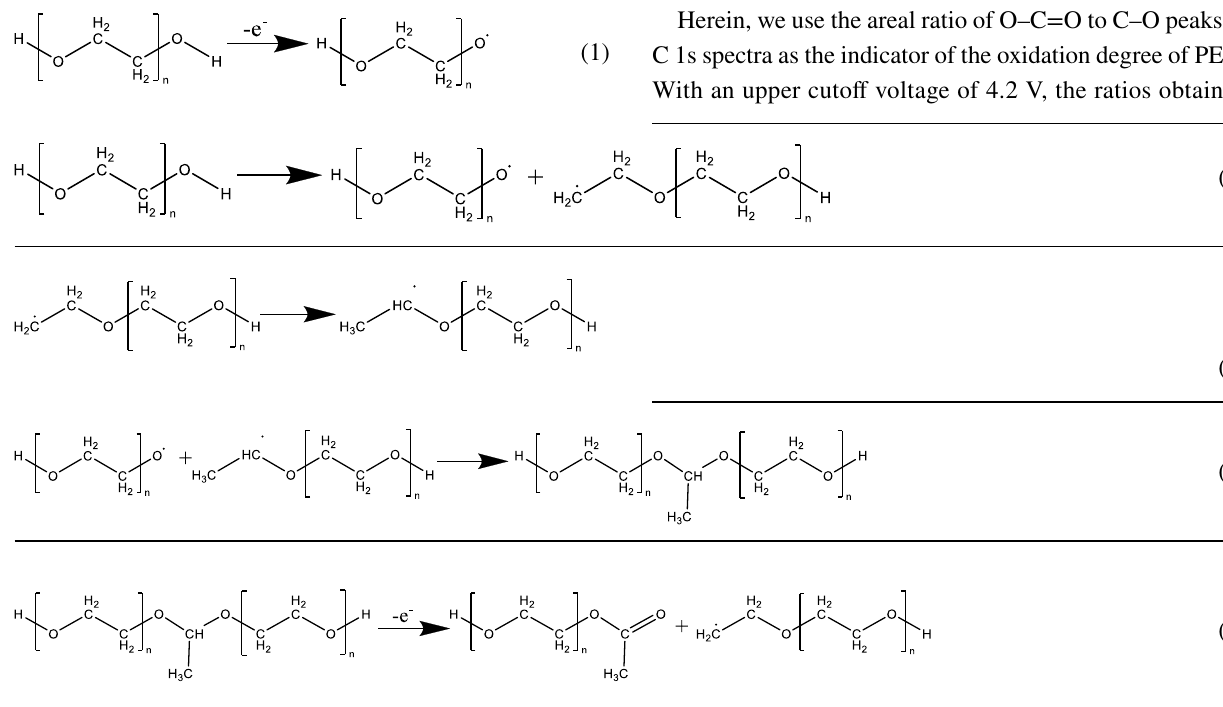
Fig. 3 C 1 s from a pristine PEO-based SPE, PEO-based SPE surface after cycling with b LCO electrode and c LAF@LCO electrode. d EIS spectra of LCO/PEO-LiTFSI/Li cell and LAF@LCO/PEO-LiTFSI/Li cell after cycling. HRTEM images of e LCO and f LAF@LCO particles after cycling. Cycled samples were obtained from the ASSLBs after 50 cycles in the voltage range of 3.0–4.2 V at